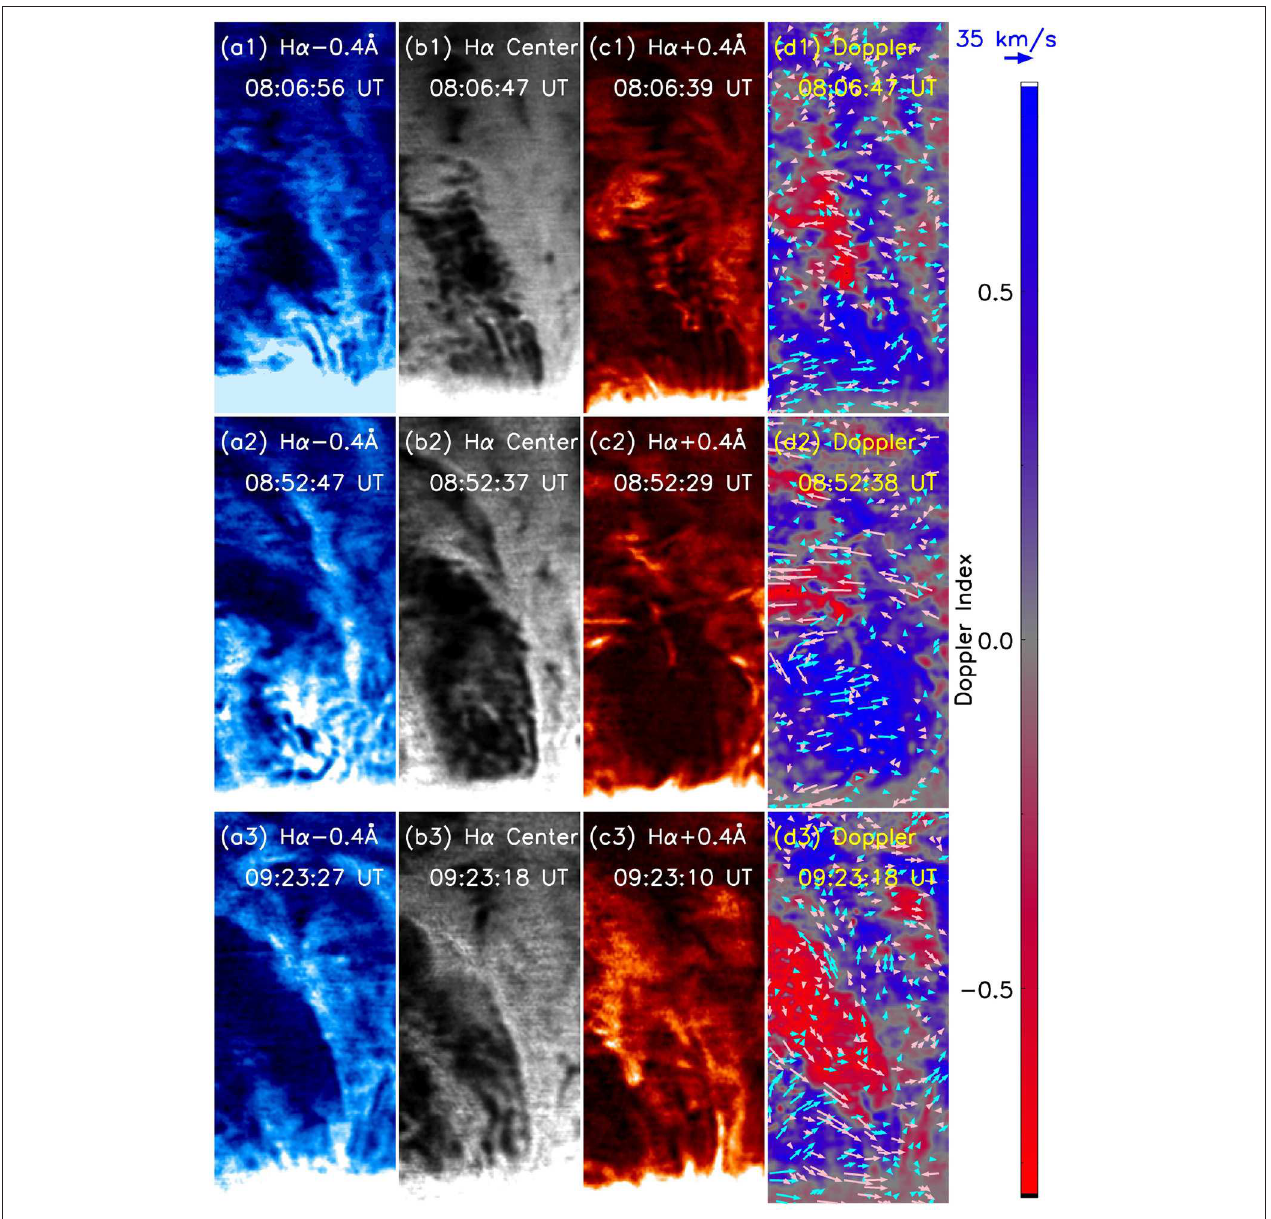
FIGURE 3 | Bubble dynamics quantified using the flow maps derived using NAVE procedure and Doppler maps. A sequence of images in the H α -0.4 Å, H α line-center, and H α +0.4 Å are shown in the first three columns (a–c) , respectively. (d1–d3) The flow map derived from the H α blue- and red-wing images is plotted in cyan and pink, respectively, on the respective Doppler maps. The blue (red) color in the doppler map represents the mass motion toward (away from) the line-of-sight. The LOS refers to the direction pointing away and orthogonal to the image